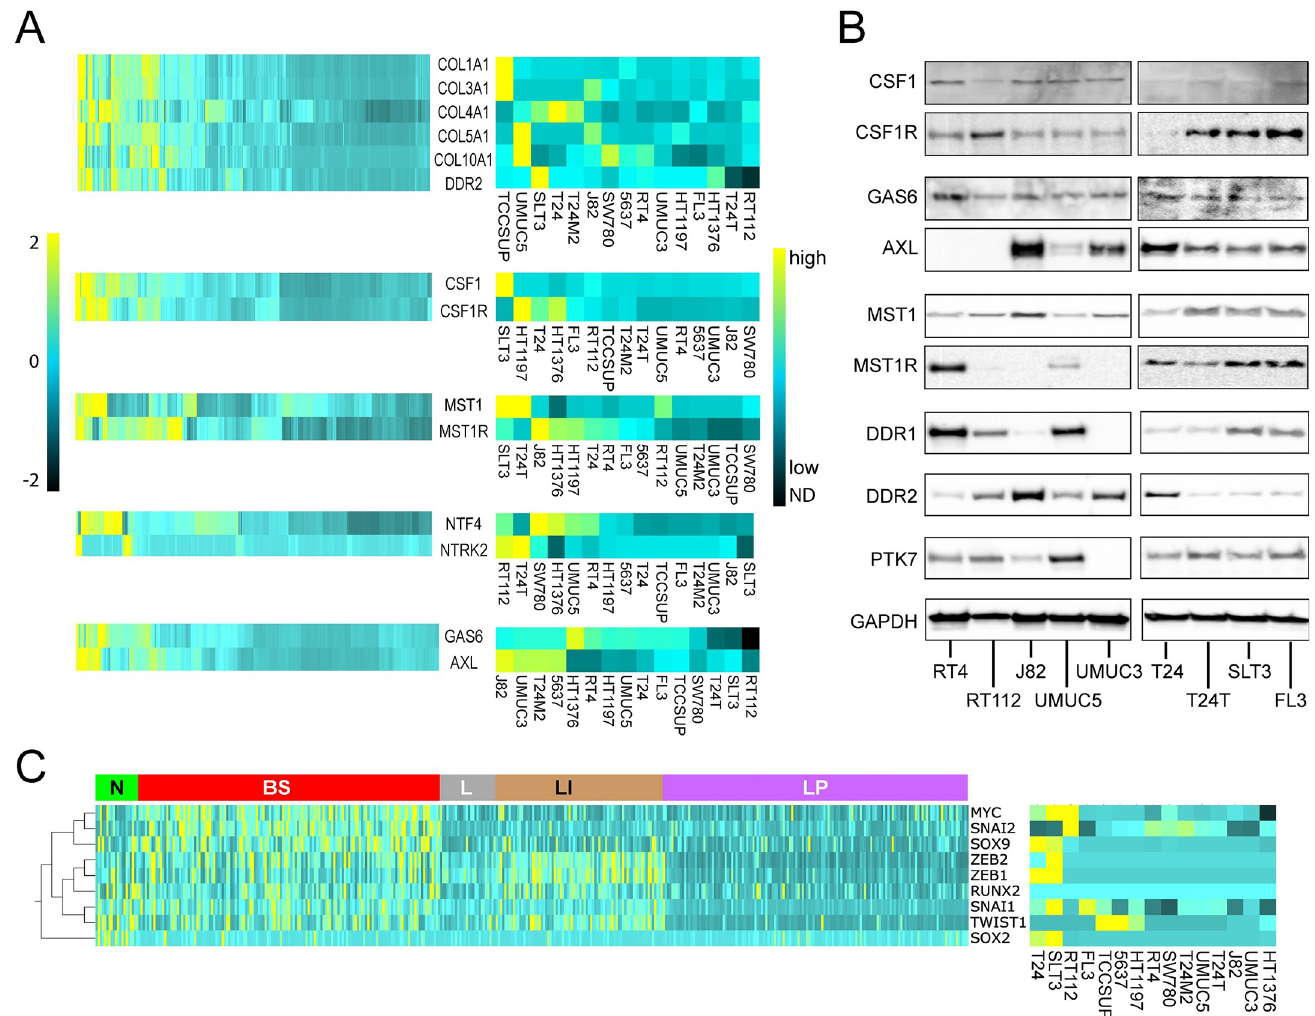
Fig 4. Potential autocrine RTK signaling in MIBC patient samples and BCa cell lines. (A) Heat map showing relative mRNA expression levels of ctRTK-cognate ligand pairs (RNA Seq V2) among 408 tumor samples from patients with MIBC [22] (left), and among 15 BCa-derived cell lines (absolute mRNA copy number, right). (B) Immunoblot detection of ctRTKs and their cognate ligands, CSF1/CSF1R, GAS6/AXL, MST1/MST1R, and evidence of DDR1, DDR2 and PTK7 proteins in 9 BCa-derived cell lines. GAPDH (bottom panel) serves as a loading control. (C) Left: heat map showing relative mRNA expression levels of 9 EMT-associated transcriptional activators (listed at right) among 408 tumor samples from patients with MIBC [22]. Samples are grouped on the horizontal axis by mRNA subtype classifications defined previously [22] indicated at the top (from left to right): neuronal (N, green); basal squamous (BS, red); luminal (L, gray); luminal infiltrating (LI, gold); luminal papillary (LP, purple), and clustered hierarchically on the vertical axis. Right: heat map showing absolute mRNA copy levels of 9 EMT-associated transcriptional activators among 15 BCa-derived cell lines (identified at bottom).